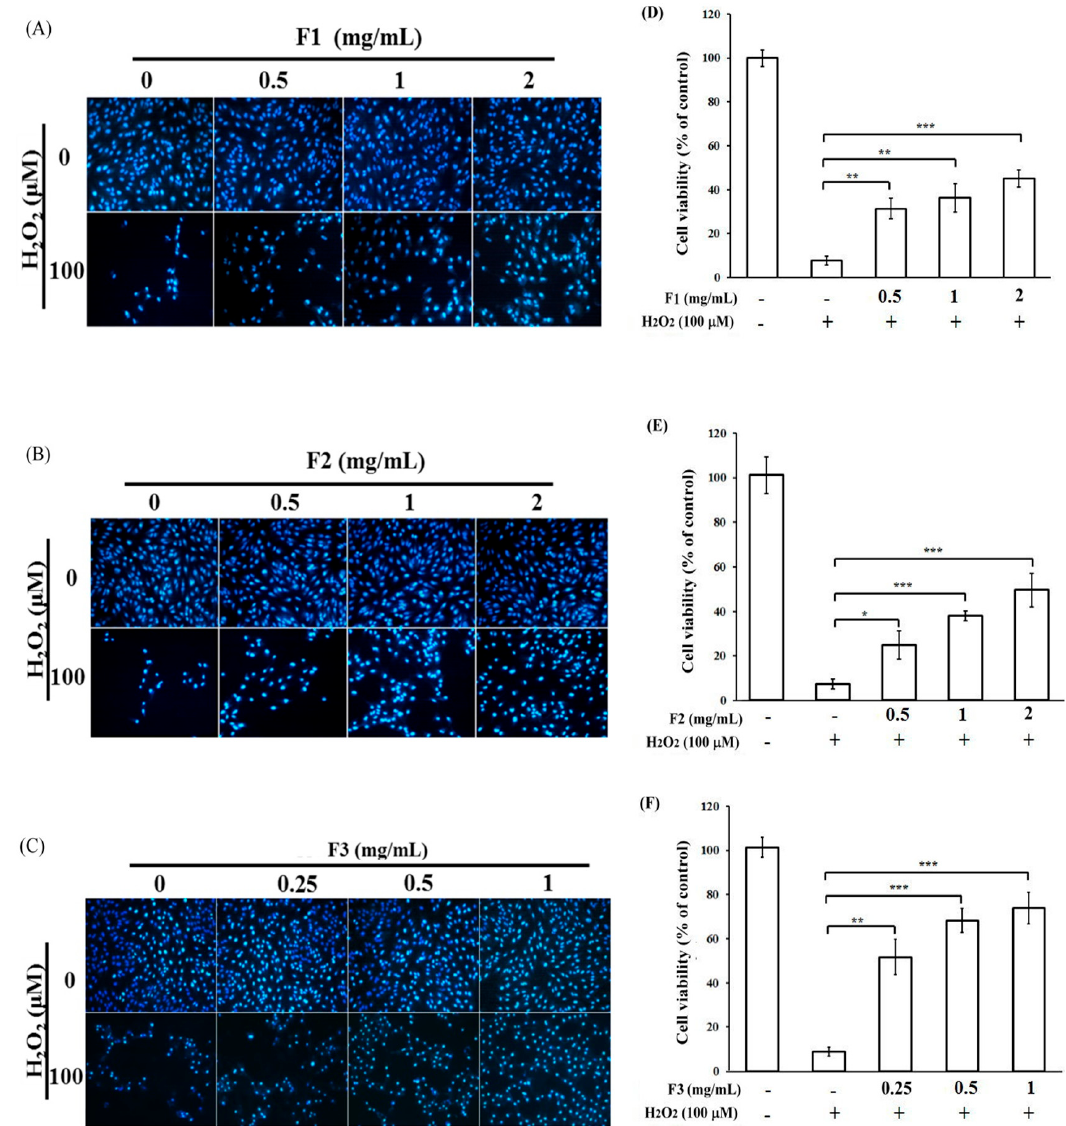
Figure 2. Effects of P. ginseng supercritical CO 2 extracted fractions on cell viability of H 2 O 2 -induced cytotoxicity in ARPE-19 cells. ARPE-19 cells were treated with or without a series of concentrations of P. ginseng supercritical CO 2 fractions for 2 h, and then treated with H 2 O 2 for another 24 h. ( A – C ) Hoechst 33342 staining; ( D – F ) Quantitative analysis of panel ( A – C ). * p < 0.05, ** p < 0.01, *** p < 0.001 versus H 2 O 2 group. Results are expressed as percentages of control, and each value represents the mean ± SD of three independent experiments.